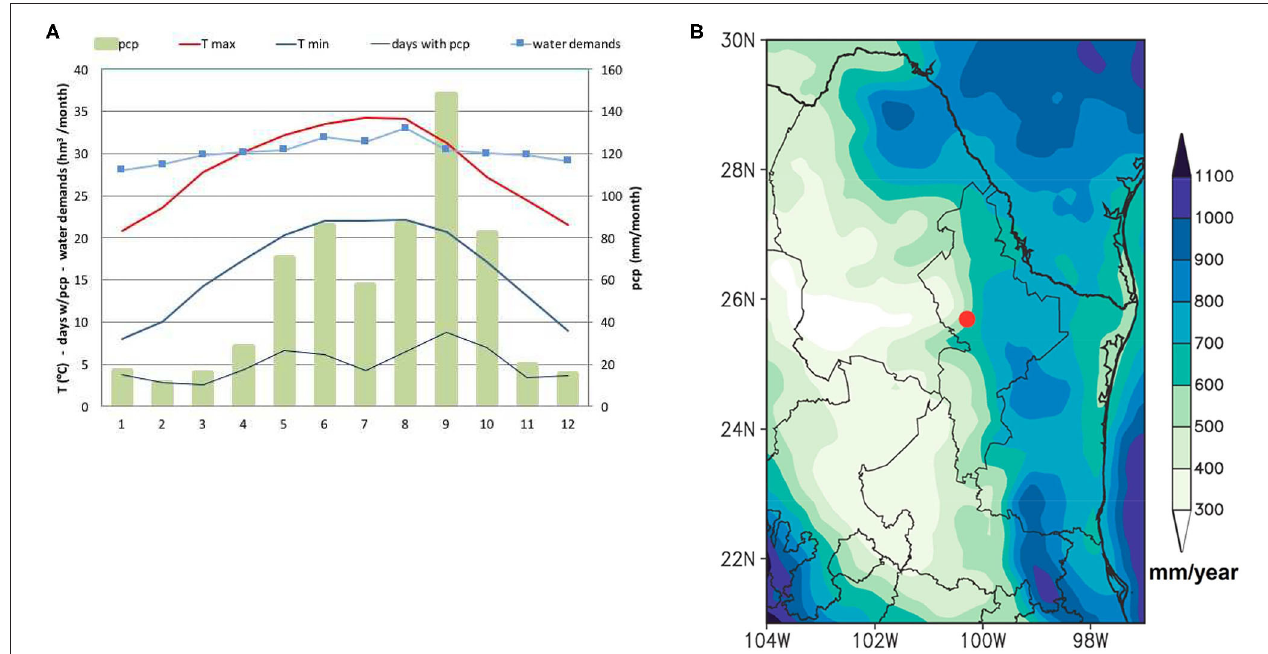
FIGURE 2 | (A) Climograph of the MMA based on CONAGUA weather station data. The red line corresponds to maximum temperature ( ◦ C), the blue line corresponds to minimum temperature ( ◦ C), and the black line to the average number of days with precipitation. Monthly water demands in the MMA (hm 3 ) are indicated with a blue line with squares. Green columns indicate monthly accumulated precipitation (mm) (B) Annual precipitation over northeastern Mexico based on CMORPH